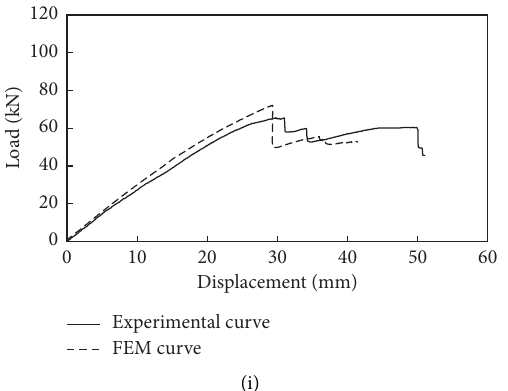
Figure 9: Comparison of numerical and experimental load-displacement curves for (a) S2D, (b) S4D, (c) S6D, (d) S4d, (e) S4DV, (f) S4DH, (g) S4DVH, (h) S4DT2, and (i) S4DT3.